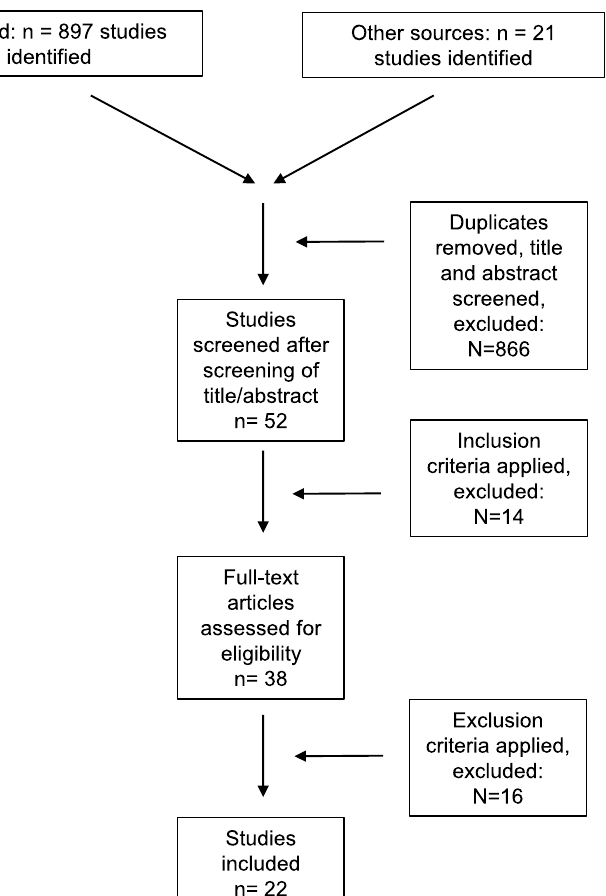
Fig. 1 Flow chart of literature search and review